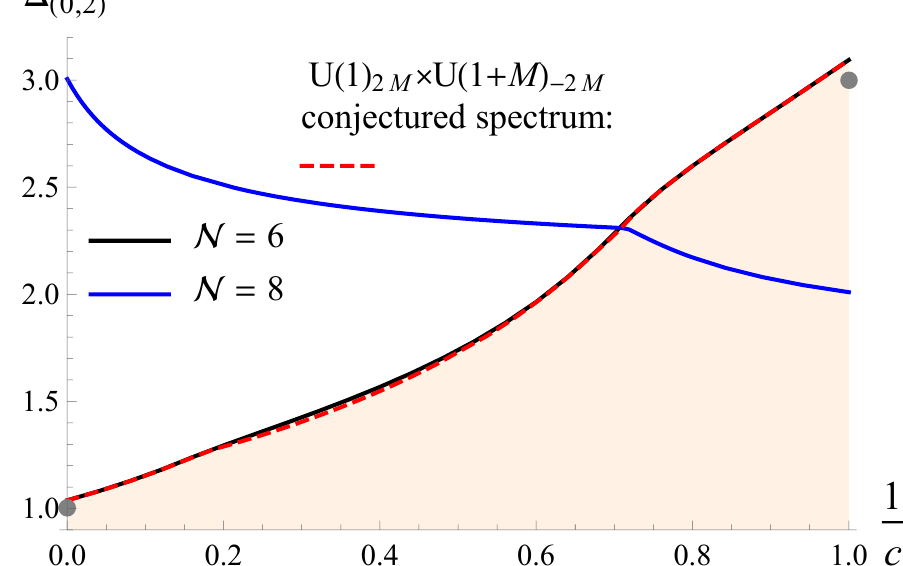
Figure 6 . Upper bounds on the scaling dimension of the lowest dimension ‘ = 0 long multiplet in terms of c T for the second superconformal structure Long [000] , 2 , which for parity preserving theories ∆ , 0 has the opposite parity as the superprimary. The orange shaded region is allowed, and the plot ranges from the GFFT limit c T → ∞ to the free theory c T = 16 . The black line denotes the N = 6 upper bound computed in this work with Λ = 39 , the blue lines denote the N = 8 upper bounds computed in [10] with Λ = 43 . At c T = 16 the N = 8 upper bound does not apply, as the N = 8 superblock becomes a conserved current that does not decompose to Long [000] , 2 . The red dashed ∆ , 0 line denotes the spectrum read off from the functional saturating the lower bound in figure 1, which we identify with the U(1) 2 M × U(1 + M ) − 2 M theory. The gray dots denote the GFFT and free theory values from table